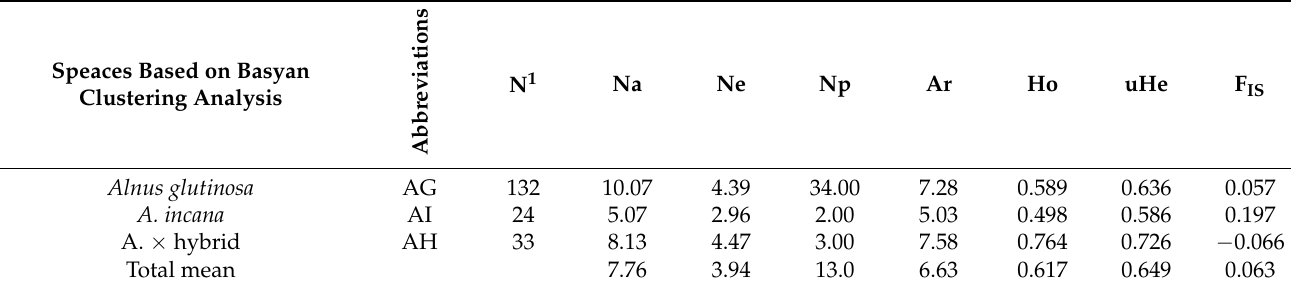
Table 1. The within-population genetic diversity parameters estimated based on 15 nSSR loci.